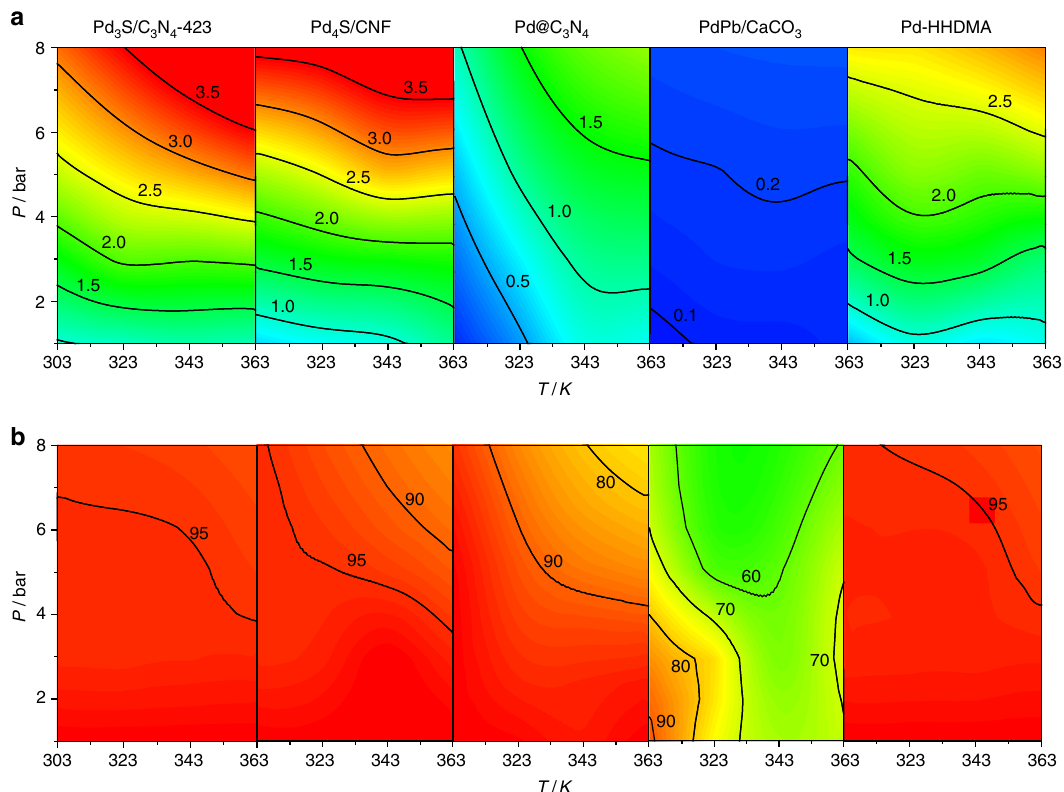
Fig. 4 Evaluation of the alkyne semi-hydrogenation performance of the catalysts. a The contour plots map the effect of temperature and pressure on the rate (in 10 3 h – 1 ) and b selectivity to 2-methyl-3-buten-2-ol (in %) of Pd 3 S/C 3 N 4 -423 compared to Pd 4 S/CNF, PdPb/CaCO 3 , Pd-HHDMA, and Pd@C 3 N 4 . Conditions: W cat = 0.1 g, T = 303 K, F L (alkyne + toluene) = 1 cm 3 min – 1 , F G (H 2 ) = 36 cm 3 min –